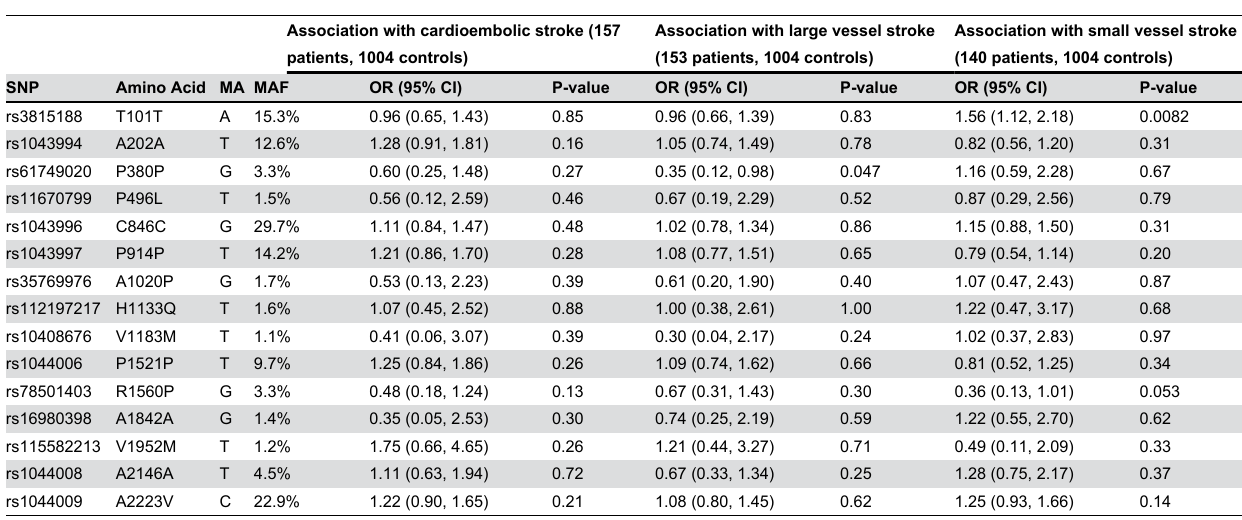
Table 5. Single SNP associations with ischemic stroke subtypes in the combined Caucasian series under an additive model.